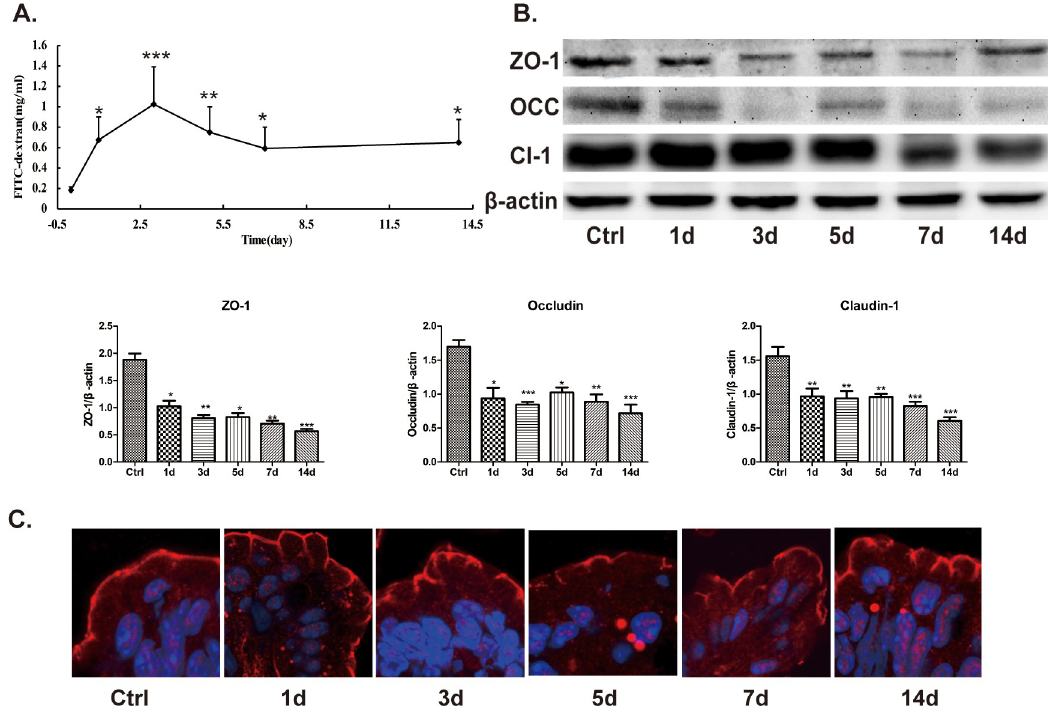
Fig 5. Antibiotics impairs intestinal barrier function. A. Intestinal permeability to 4.4 kDa FITC-dextran was significantly increased after antibiotics treatment. Data represent the mean ± SEM (n = 6). � p < 0.05, �� p < 0.01, ��� p < 0.001 compared with control. B. Antibiotics significantly decreased proteins expressions of ZO-1, occludin and claudin-1. Data represent the mean ± SEM (n = 6). � p < 0.05, �� p < 0.01, ��� p < 0.001 compared with control. OCC: occludin, CL-1: claudin-1. C. ZO-1 (red) was mainly localized to the epithelial tight junctions in the ileum of control mice. In contrast, antibiotics disrupted the normal arrangement of ZO-1 at the apical junctions. Data are representative of three independent experiments. Scar bar = 10.0 μ m.